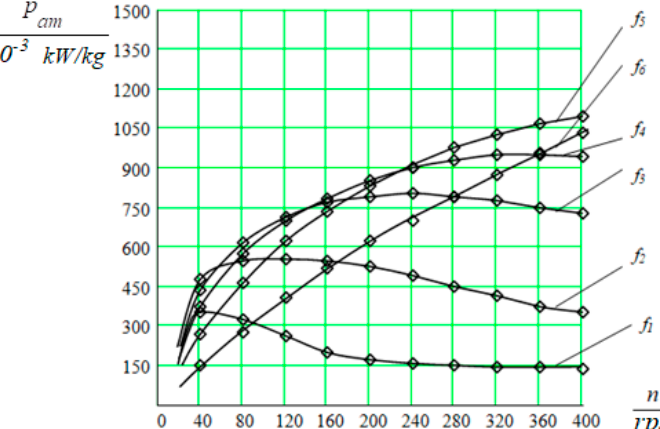
Figure 7. Dependences of the specific power p am on rotation frequency at different frequencies of current: f 1 = 400 Hz; f 2 = 1000 Hz; f 3 = 2000 Hz; f 4 = 3000 Hz; f 5 = 5000 Hz; f 6 = 10,000 Hz.